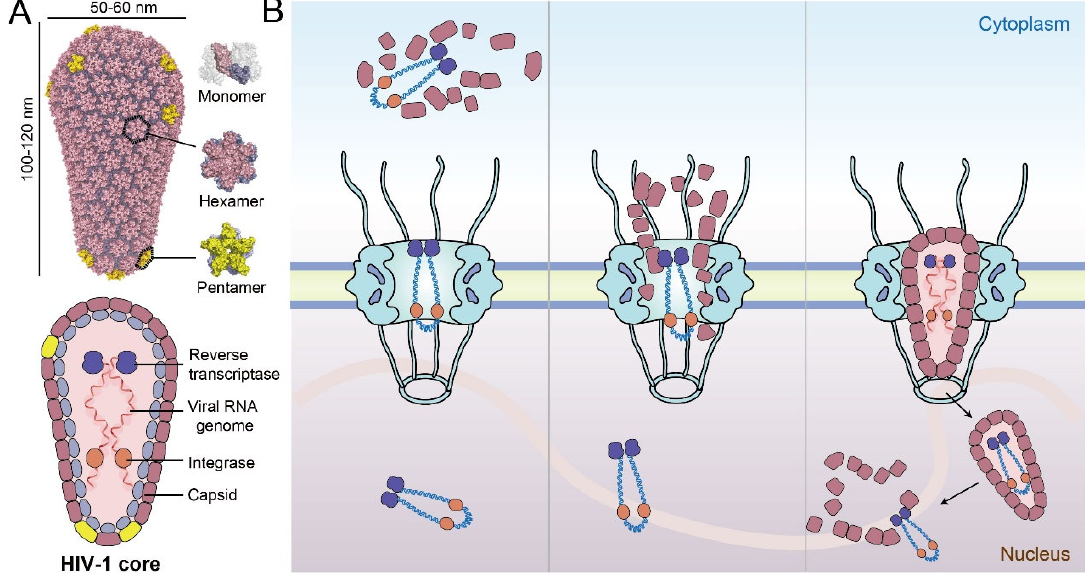
Figure 1. Schematic overview of the HIV ‐ 1 core and three potential models of nuclear import. ( A ) The cone ‐ shaped viral capsid is assembled from CA hexamers and pentamers. The viral genome and necessary enzymes such as integrase and reverse transcriptase are housed inside the capsid. ( B ) Left panel—model of early uncoating in the cytosol after the virus core enters the cell; middle panel—capsid uncoating at the NPC; right panel—penetration of the intact HIV ‐ 1 core through the NPC and completion of reverse transcription and uncoating in the nucleus.